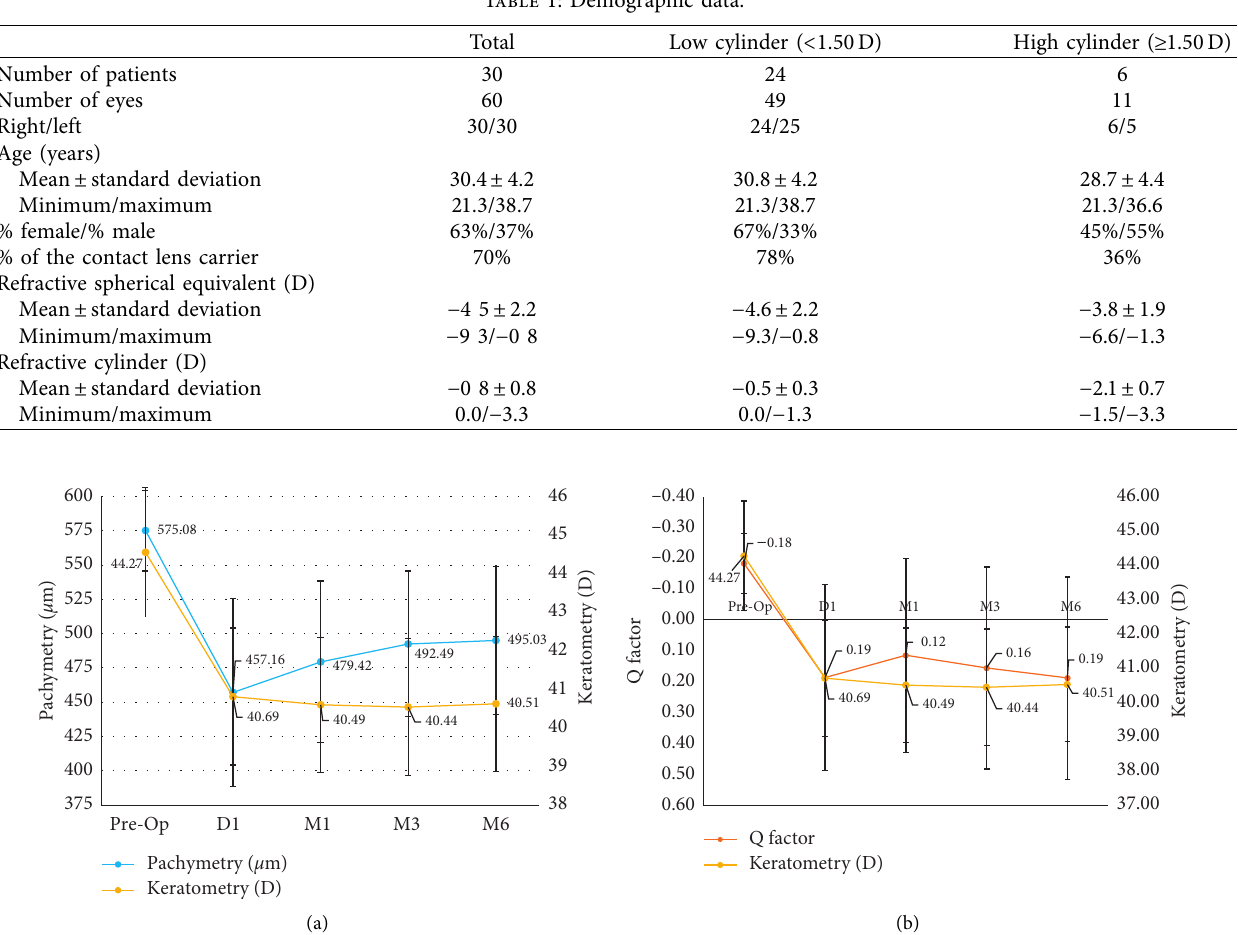
Figure 3: Evolution of anatomical parameters after myopic LASIK. (a) Evolution of pachymetry with regard to keratometry. (b) Evolution of keratometry with regard to asphericity.